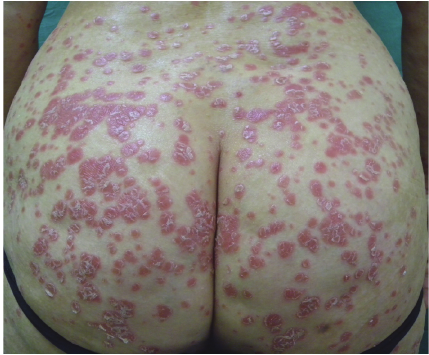
Figure 2: Erythematous scaly lesions of the buttocks in a patient a ff ected by